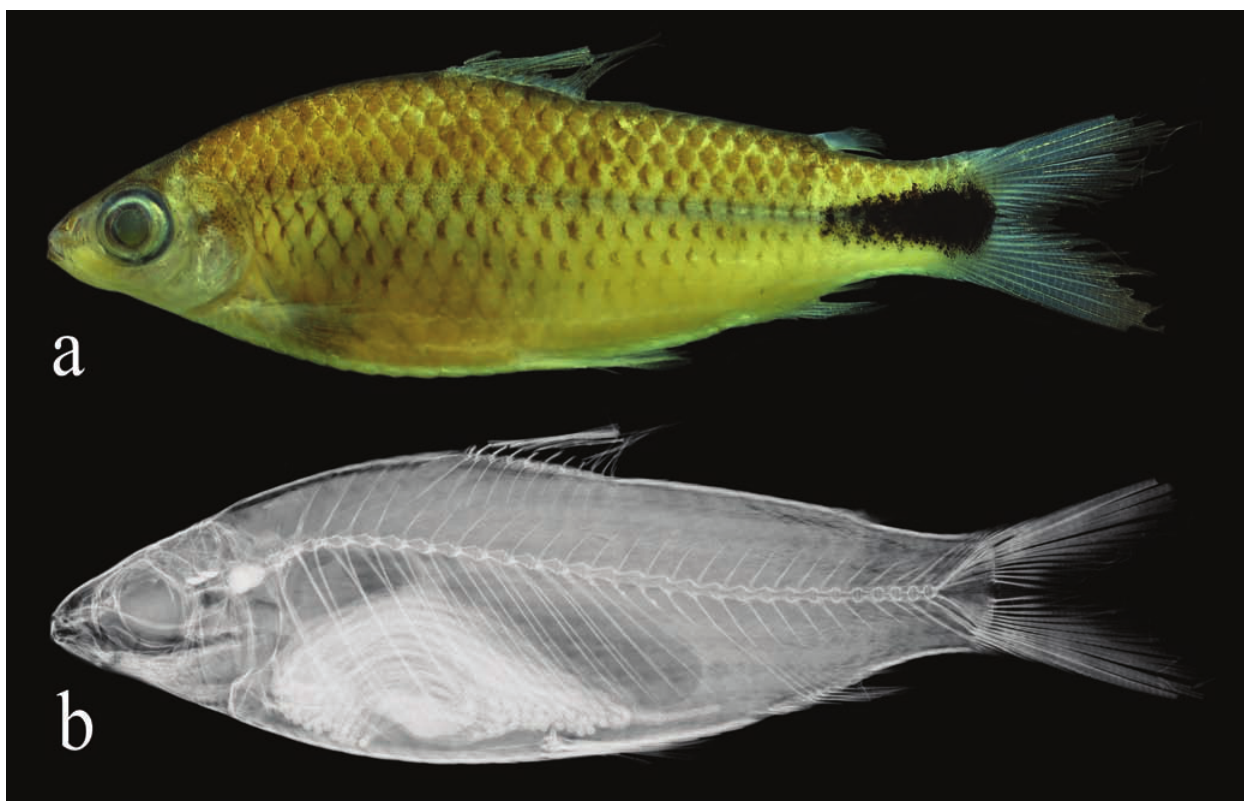
Fig. 1. Cyphocharax sanctigabrielis , holotype, MZUSP 115004, 60.7 mm SL, Igarapé Nouba Uba, rio Negro, Amazon basin, São Gabriel da Cachoeira, Amazonas State, Brazil. Views of preserved specimen (a) and radiograph